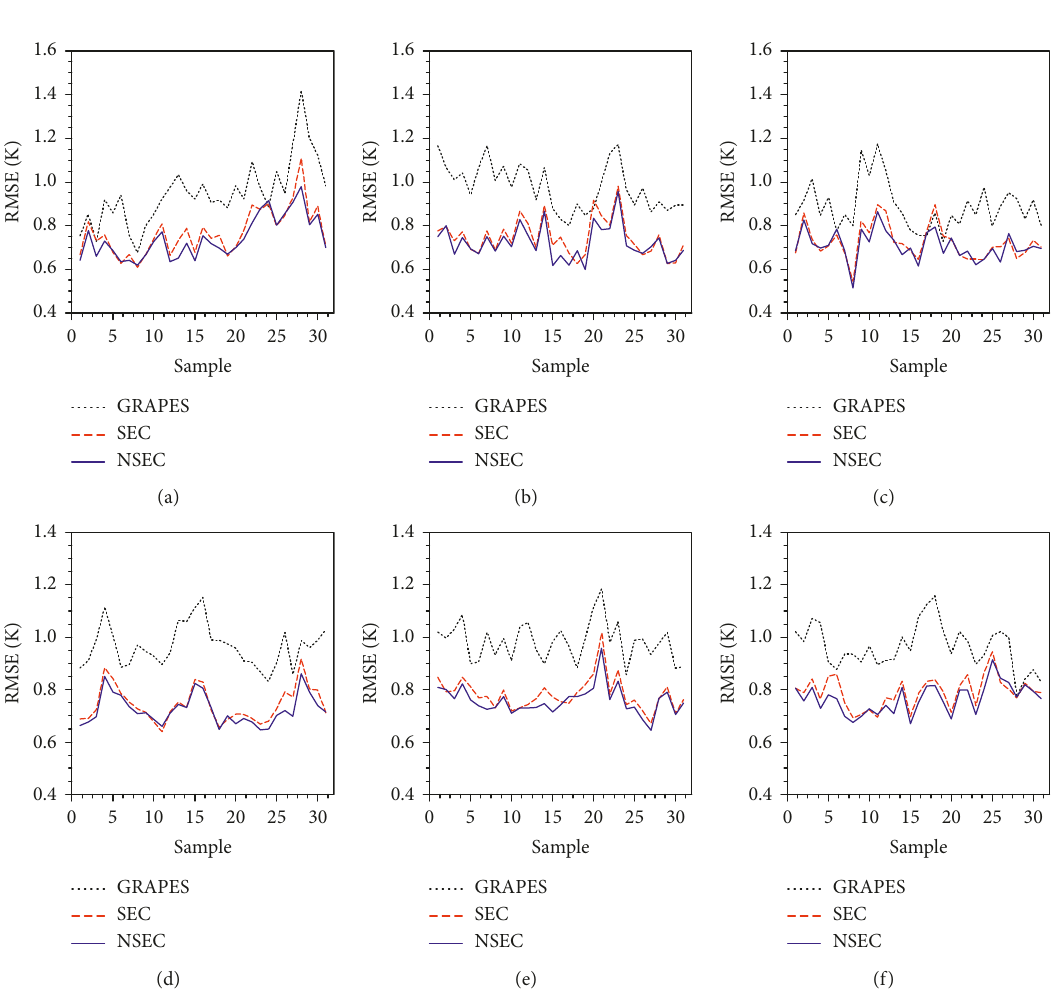
Figure 8: RMSE of 500hPa temperature of 24 h forecast at January (a, b, and c) and July (d, e, and f) of 2008, 2009, and 2010. The black lines (GRAPES) denote GRAPES model forecast, red lines (SEC) to the forecast after system correction, and blue lines (NSEC) to the forecast after correction of nonsystematic error. Table 7: Average of RMSE of test samples of temperature on 500hPa (unit: K). Test month